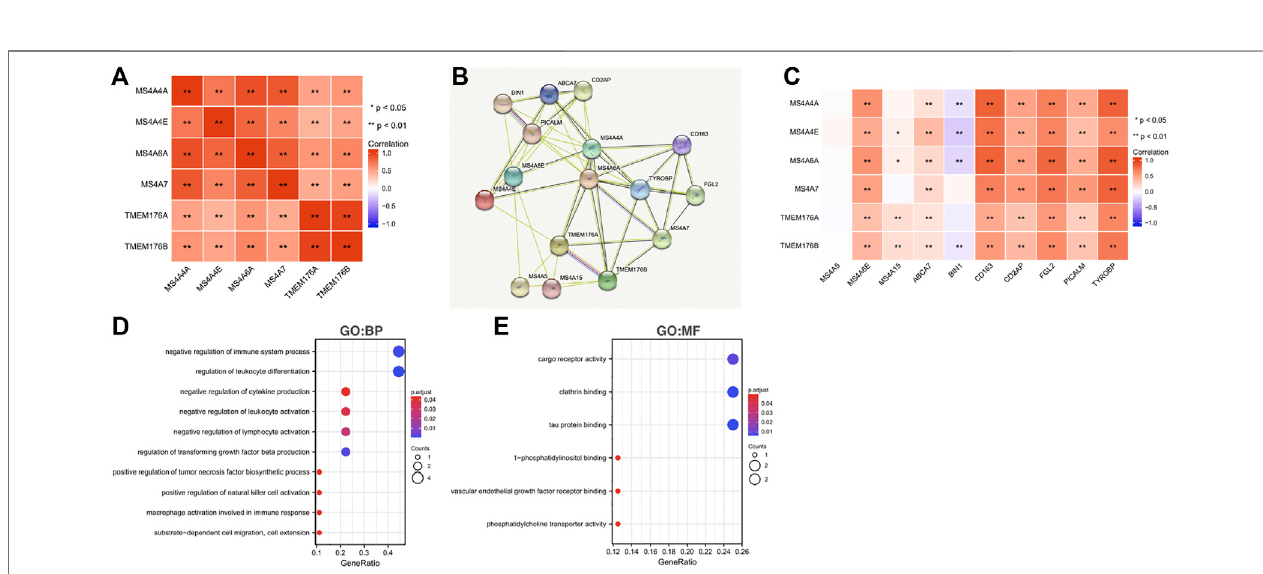
FIGURE 6 | Predicted pathways and correlations of the MS4A expression in glioma. (A) Spearman ’ s correlation coef fi cients were used to study the correlations among MS4As; (B) PPI network for MS4As was constructed in STRING; (C) GO terms related to biological processes (BPs) are shown in a bubble chart; (D) GO terms related to molecular functions (MFs) are shown in a bubble chart; (E) Spearman ’ s correlation coef fi cients were used to study the association between MS4As and ten key genes.